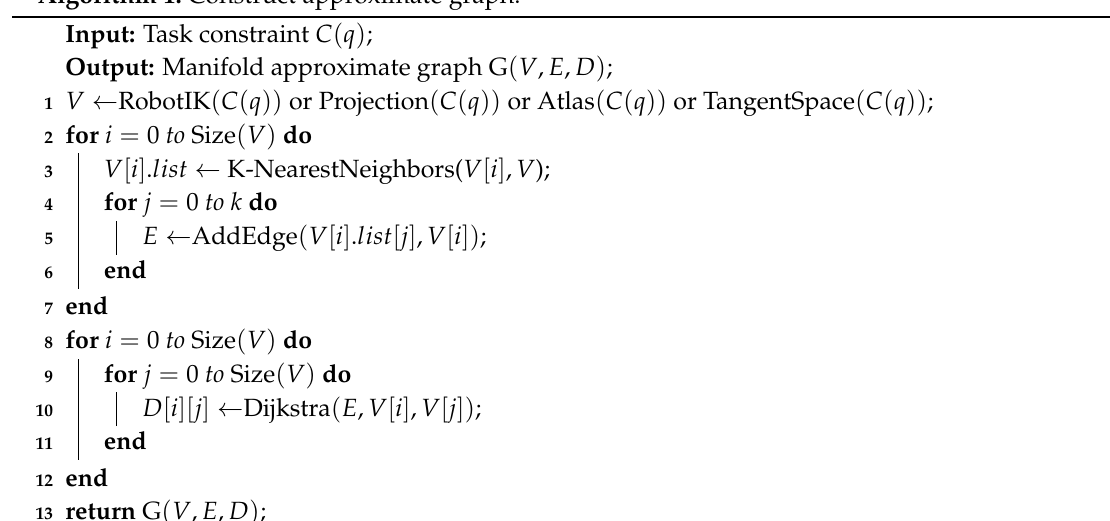
Algorithm 1: Construct approximate